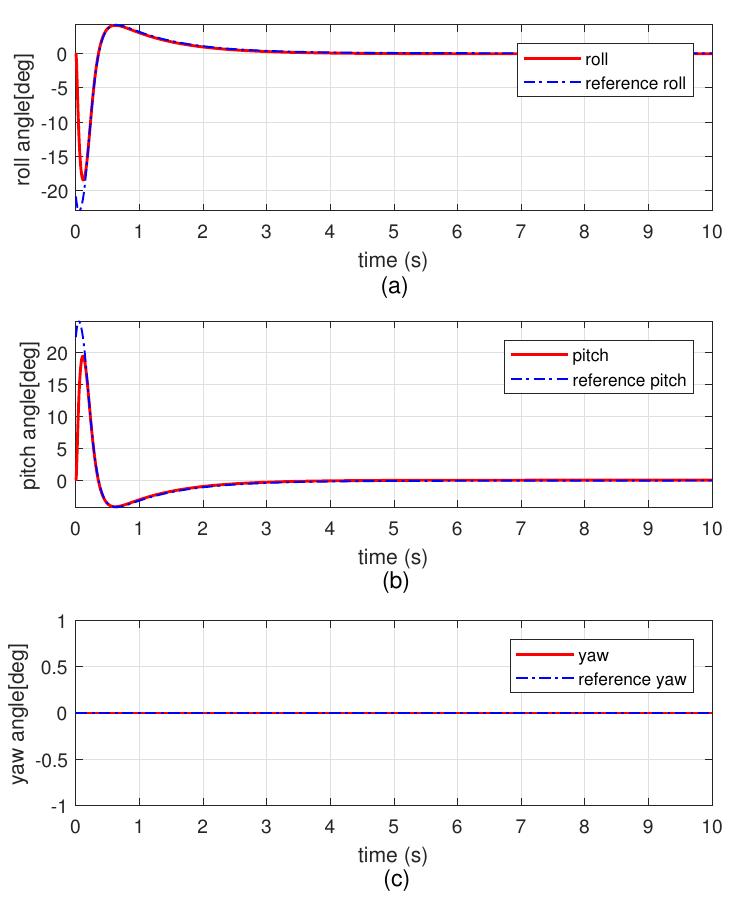
Figure 5. The attitude response for the position control. The dashed line indicates the reference attitude angles that enable the quadrotor to converge in the desired position, and the solid line is the result of the simulation about attitude responses of a quadrotor: ( a ) θ ; ( b ) ψ ; ( c ) φ